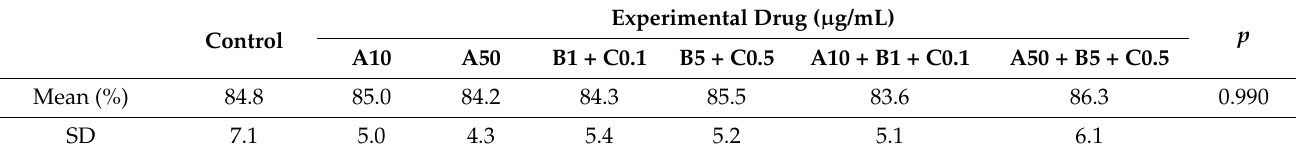
Table 2. Effects of the experimental drugs on cell viability by cell count experiment in SH-SY5Y cells ( n = 5).